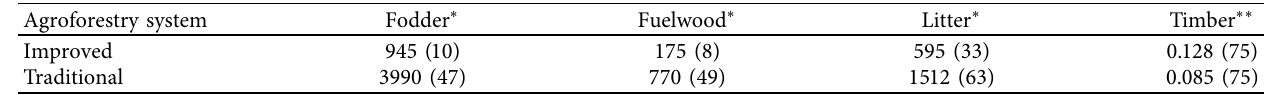
Table 4: Deficit products from the agroforestry system at the local